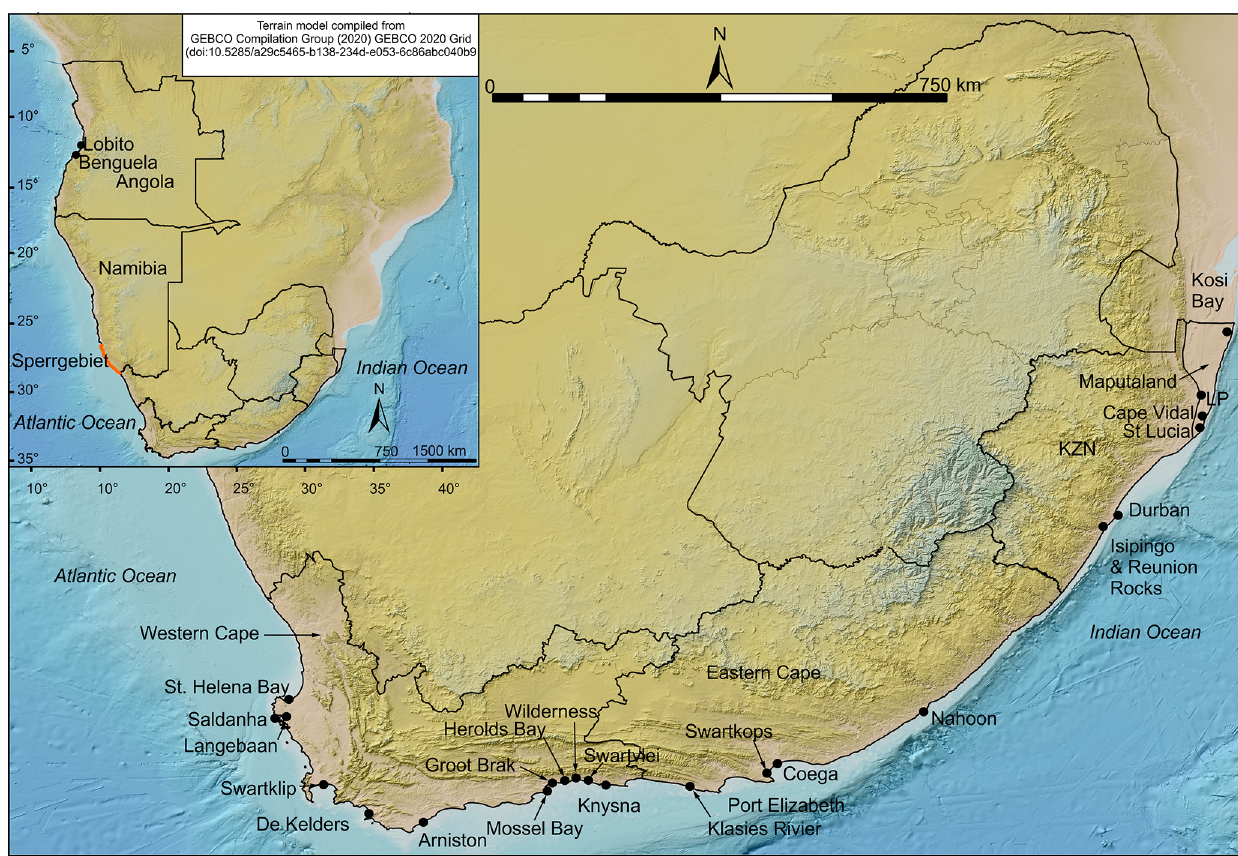
Figure 1. (Inset) Locality Map of the Angolan, Namibian and South African coasts showing sites mentioned in the text. Main map shows details of sites in South Africa (KZN: KwaZulu-Natal province; LP: Lister’s Point). Co-ordinates for each site are provided in the database.